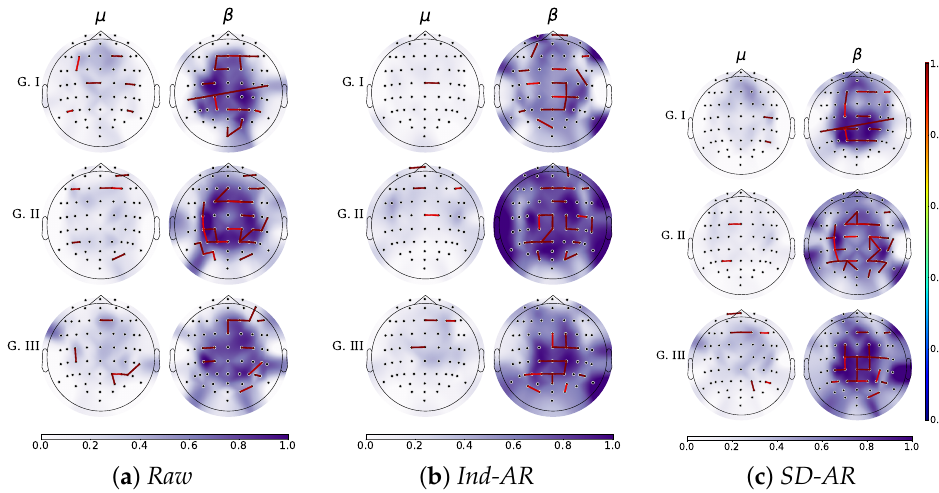
Figure 6. Topoplots show the GFC’s spatial relevance for each considered group of skill partition. The GFC links only exceeding relevance weight values of 0.9 are depicted. The strength values over each electrode estimate the background activity elicited by MI responses.